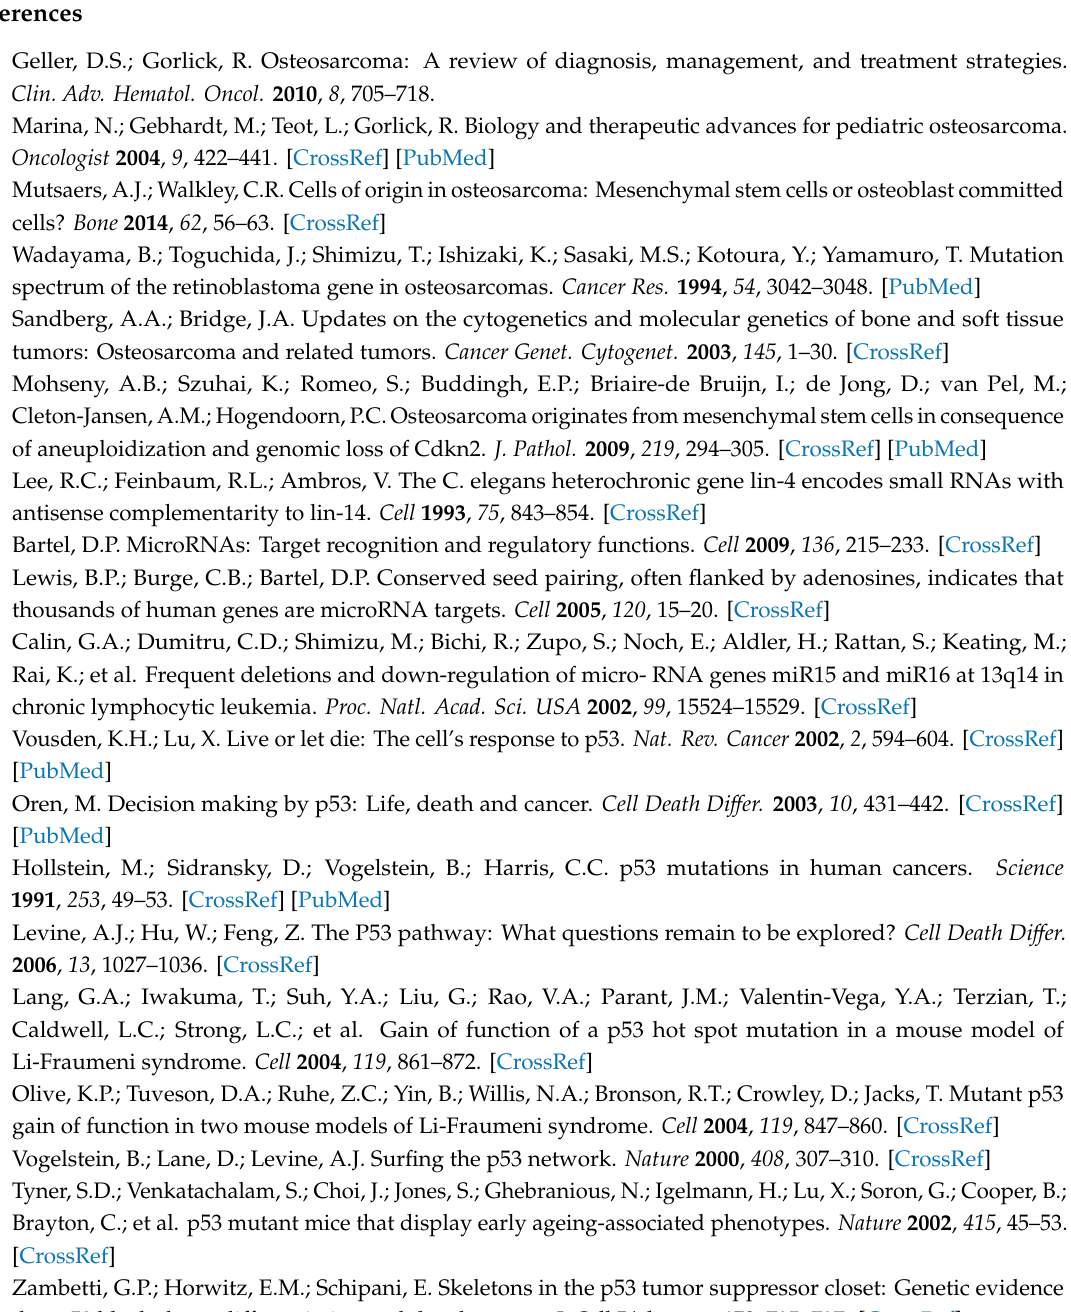
Table S1: The p53-related miRNAs and the nature of the interaction with their target